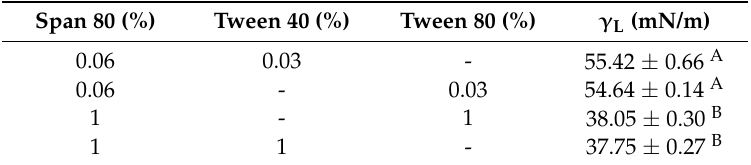
Table 1. Interaction effect of surfactants on surface tension ( γ L ) values of coating solutions. Each formulation (each row) was incorporated into 1.25% sodium alginate + 2% glycerol + 0.05% sunflower oil solutions ( n = 3).